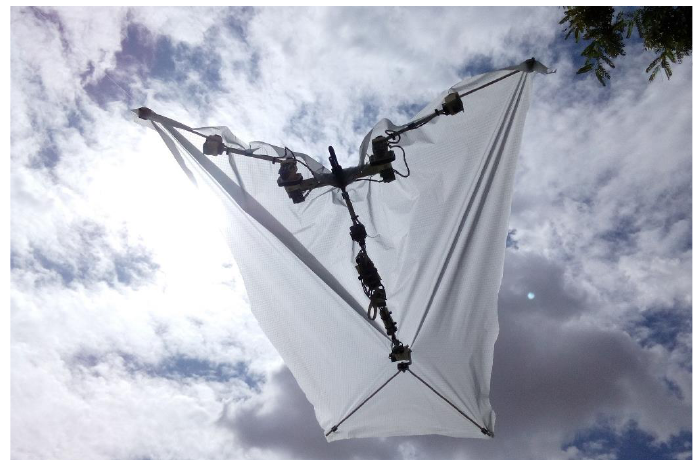
Figure 1. Prototype of winged aerial manipulation robot with dual arm and tail. Table 1. Biomechanical parameters of some bird species.